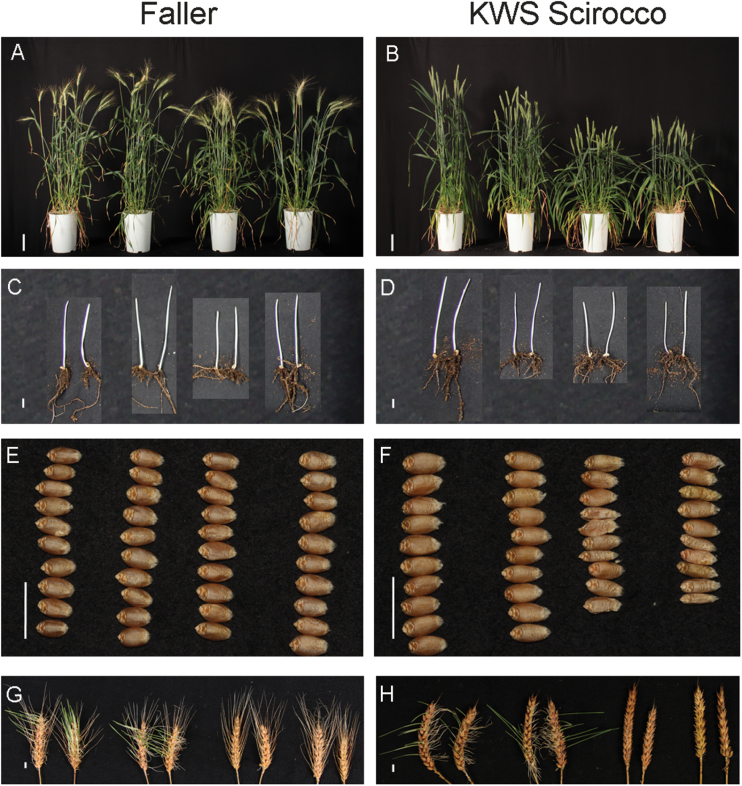
Phenotypic effects of three ovg alleles, compared with the respective reference allele, in Faller and KWS Scirocco. From left to right: reference allele (Rht-B1b for Faller, Rht-B1a for KWS Scirocco), Rht-B1c.22, Rht-B1c.23, and Rht-B1c.26. (A, B) Flowering plants 3 months after sowing; scale bar=10 cm. (C, D) Etiolated coleoptiles when 50% of the second leaf was visible; all leaves were removed on the picture; scale bar=1 cm. (E, F) Ten grains; scale bar=1 cm. (G, H) Sprouted spikes, harvested at physiological maturity from plants grown in the greenhouse; scale bar=1 cm.